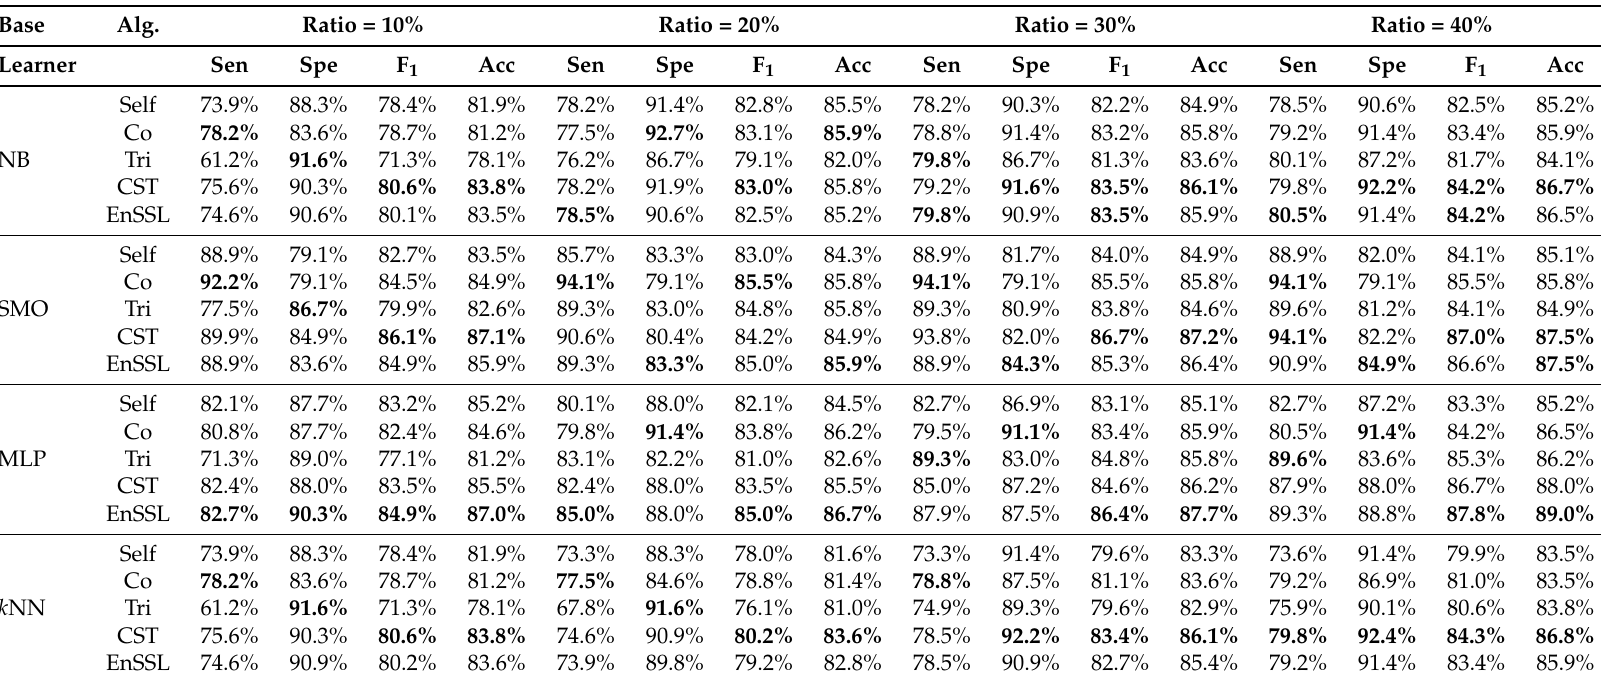
Table 2. Performance evaluation of Self-training, Co-training, Tri-training, CST-Voting and EnSSL on the Australian credit